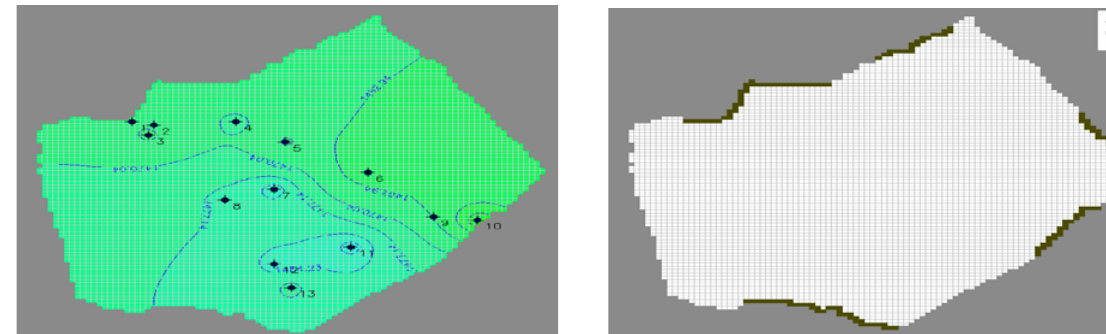
Talebi S, et al. Optimization of Artificial Recharge. J Adv Environ Health Res. 2022;